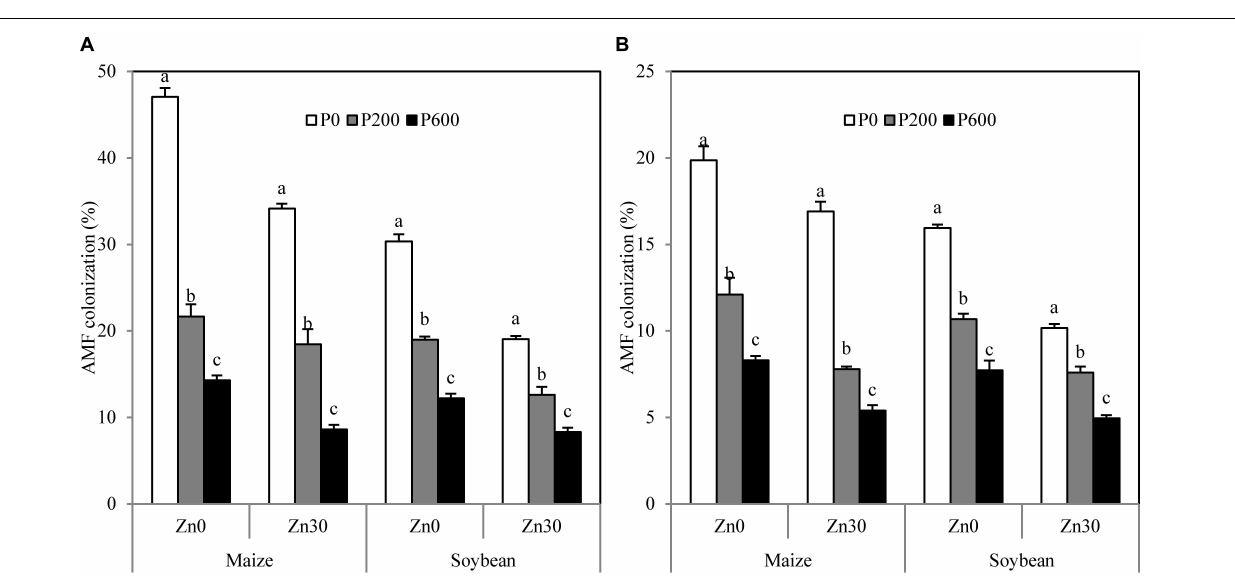
FIGURE 3 | Arbuscular mycorrhizal fungi (AMF) colonization of maize and soybean affected by P and Zn applications without benomyl (A) and with 0.4 g benomyl kg − 1 soil (B) addition, respectively. Values are means of three replications. The same lowercase letter indicates no significant difference among P application levels ( P < 0.05). Zn0 and Zn30 represent 0 and 30 mg Zn kg − 1 soil rates, respectively. P0, P200, and P600 represent 0, 200, and 600 mg P kg − 1 soil rates,